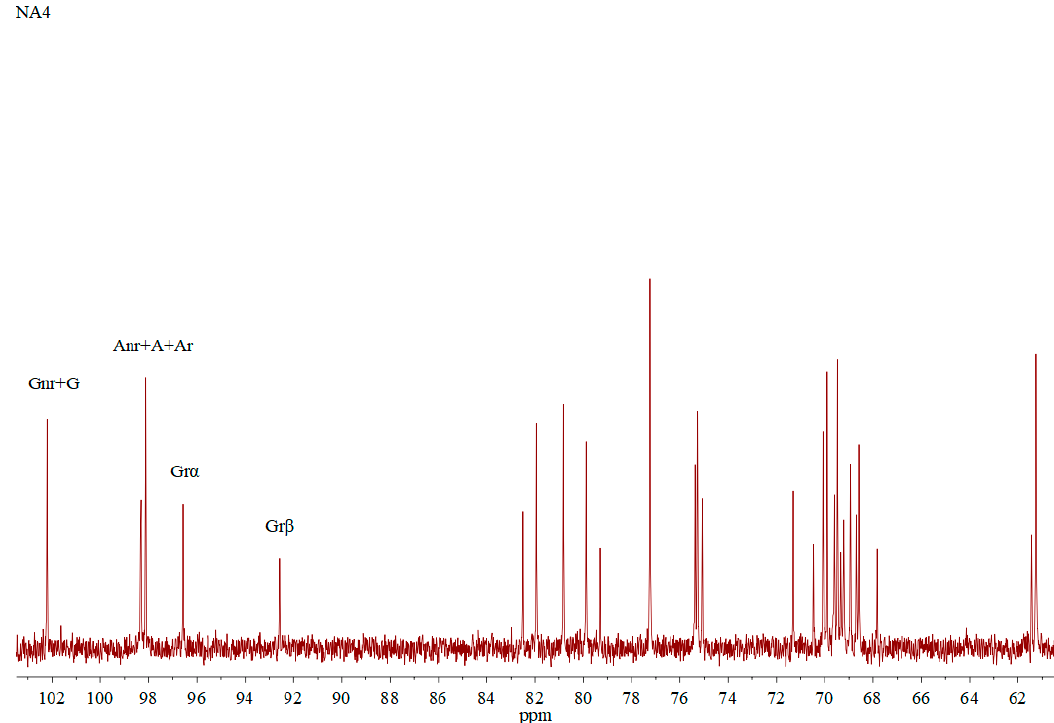
Figure 9. 13 C NMR spectra of NA4. Table 4. Chemical shift assignments for 13 C-NMR spectra of NAOS.